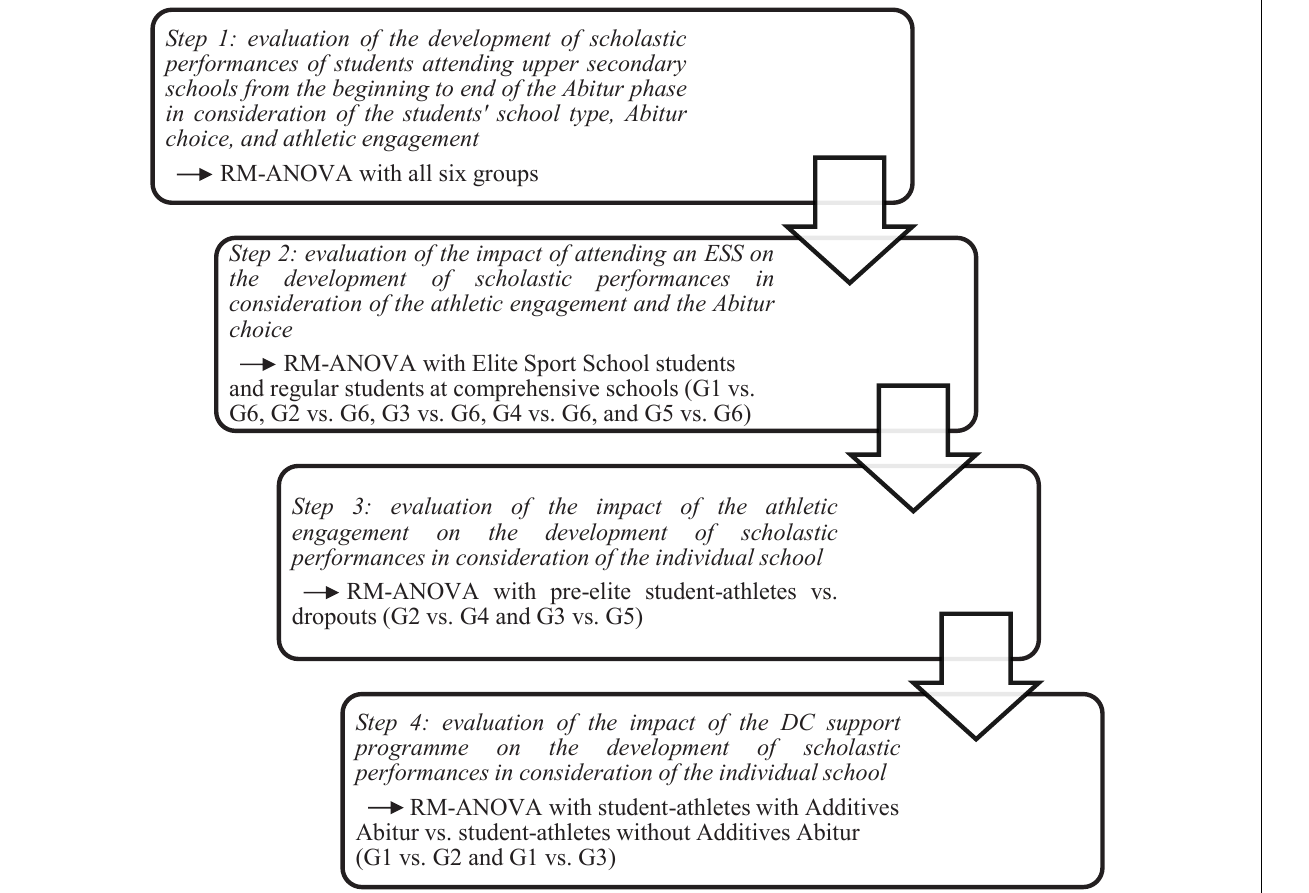
FIGURE 2 | Steps conducted in the data analysis. RM-ANOVA, repeated-measures analysis of variance; G1, student-athletes with Additives Abitur at Elite Sport School 1; G2, student-athletes without Additives Abitur at Elite Sport School 1; G3, student-athletes without Additives Abitur at Elite Sport School 2/3; G4, dropouts at Elite Sport School 1; G5, dropouts at Elite Sport School 2/3; G6, non-student-athletes at comprehensive